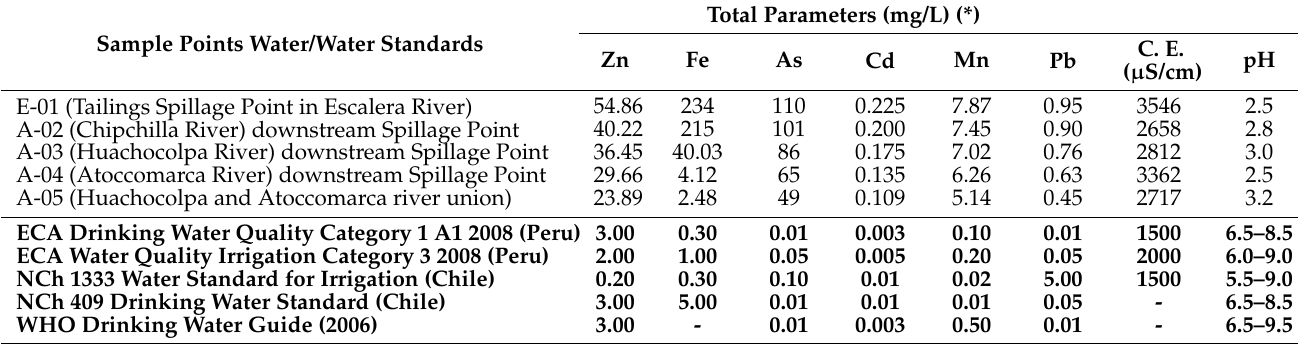
Table 2. Water Monitoring in the Escalera River—Compared to Water Standards [48–51].